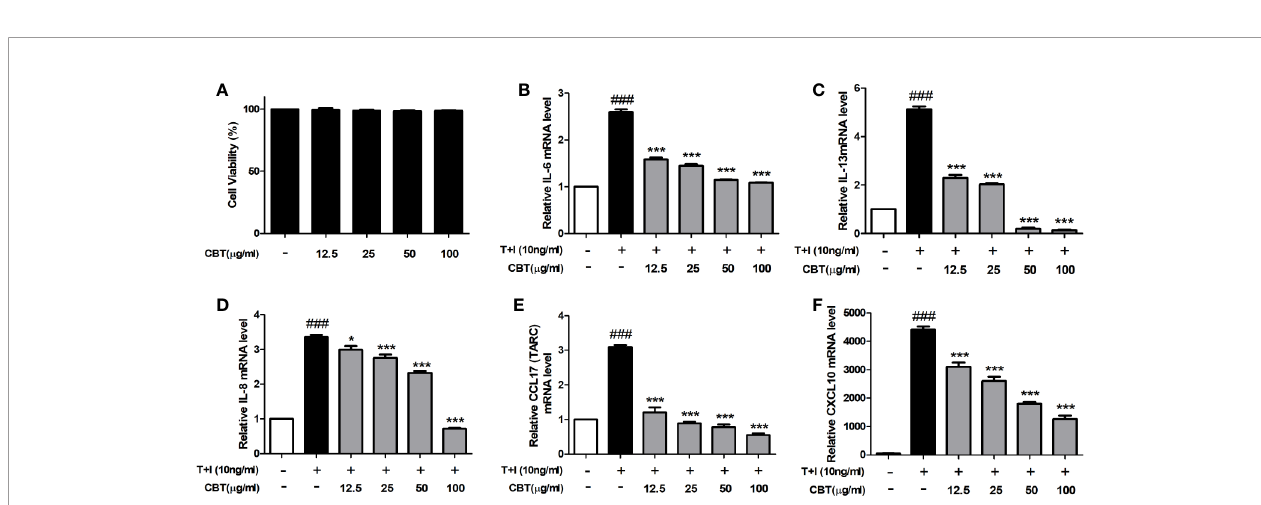
FIGURE 2 | Effects of Chijabyukpi-tang (CBT) on the mRNA expression levels of pro-in fl ammatory cytokines and chemokines in TNF- a /IFN- g -stimulated HaCaT cells. Cell viability of CBT was measured using MTT assay. The group that did not treatment anything was set as negative control (A) . Cells were incubated for 24 h in the presence of CBT (12.5 to 100 m g/ml) or in the absence of CBT (media only). HaCaT cells were pretreated with several concentrations of CBT (12.5, 25, 50, and 100 m g/ml) for 2 h and then stimulated with TNF- a /IFN- g (each 10 ng/ml) for 3 h. The mRNA expression levels of IL-6 (B) , IL-13 (C) , IL-8 (D) , CCL17 (E) , and CXCL10 (F) were determined using quantitative real-time polymerase chain reaction (qPCR). Data are shown as mean ± SEM of the three independent experiments. ### p < 0.001 compared with the no-treatment condition, *p < 0.05, and ***p < 0.001 compared with the only TNF- a /IFN- g treatment